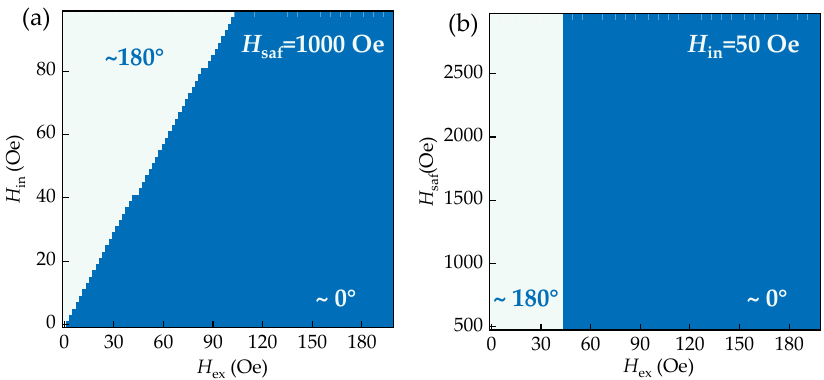
Figure 5. Heatmaps of the pinning direction: ( a ) the dependence of θ P1 on H in and H ex ; ( b ) the dependence of θ P1 on H sat and H ex .